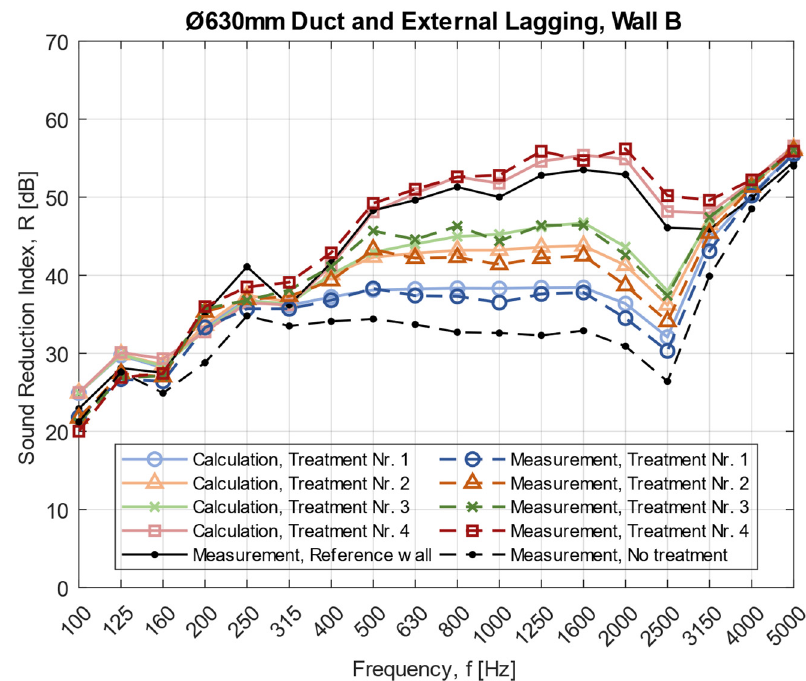
Figure A4. Theoretical models compared to measurements with external lagging as acoustic treatment. Ventilation duct with Ø315 mm through wall B with a sound reduction index of R w = 46 dB. External lagging is mounted at partial lengths of 0.6–1.8 m (Treatment 1–3) and full length (Treatment 4) with 50 mm stone wool, density of 100 kg/m 3 , closest to the wall.